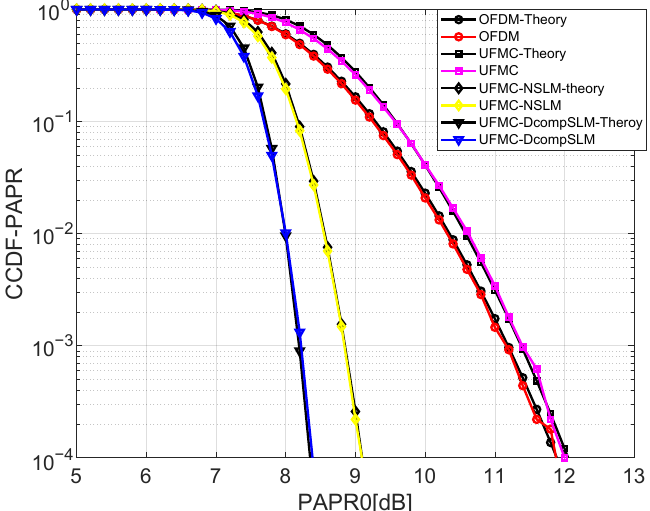
Figure 3. CCDF-PAPR of UFMC format and orthogonal frequency division multiplexing (OFDM)with N = 512 and 16-QAM modulation, at U = 6 phase vectors for normal SLM (NSLM) and Dcomp-SLM